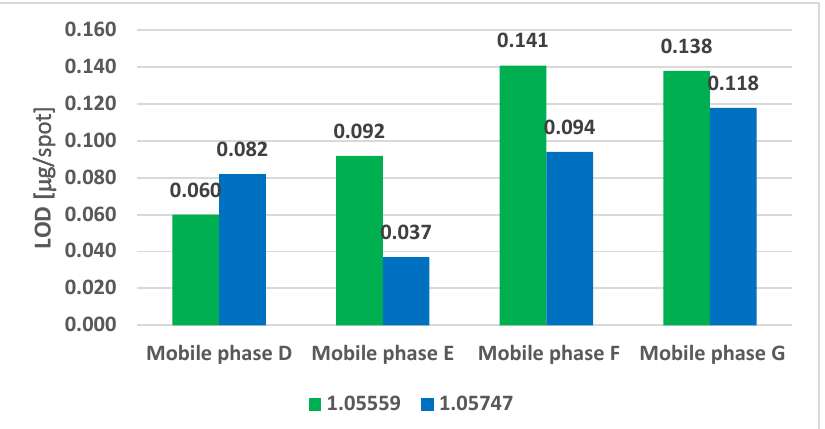
Figure 8. Mean values of the limit of detection of sertraline, obtained by the method of partition thin-layer chromatography, where the mobile phases were as follows: D—methanol + water, 10:0 ( v/v ); E—methanol + water, 9:1 ( v/v ); F—acetone + water, 10:0 ( v/v ); G—acetone + water, 9:1 ( v/v ). The chromatographic plates were : 1.05747 — silanized silica gel 60F 254 (RP-2) on glass plates; 1.05559—silica gel RP-18F 254 on aluminum plates.